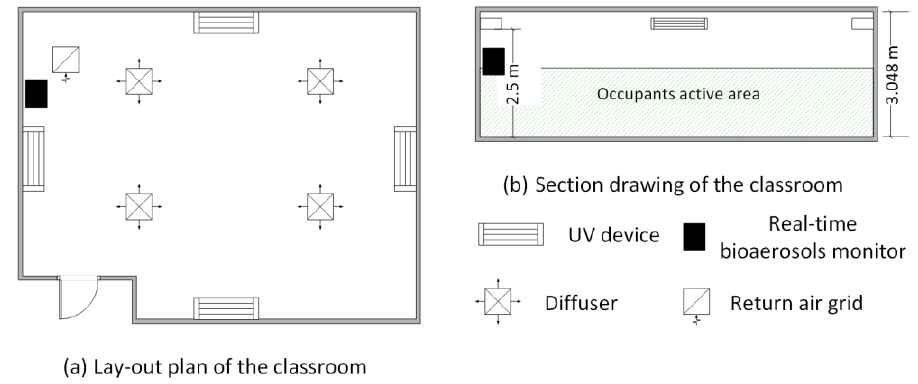
Figure 1. Floor plan of the classroom and location of the real-time bioaerosol monitors (RBMs) ( a ) Lay-out plan of the tested classrooms with locations of UV devices and RBM; ( b ) Section drawing of the tested classrooms showing the heights of UV devices and RBM. UV: ultraviolet.